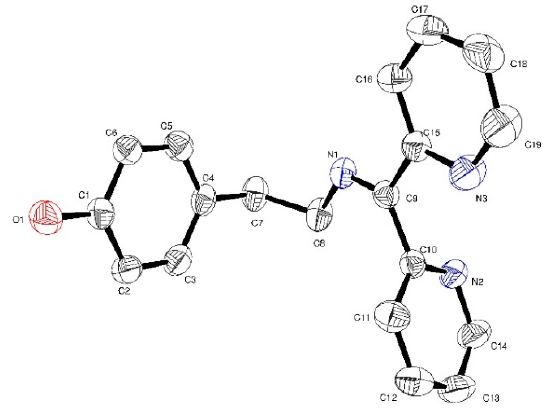
Figure 4. Crystal structure of compound 3 .